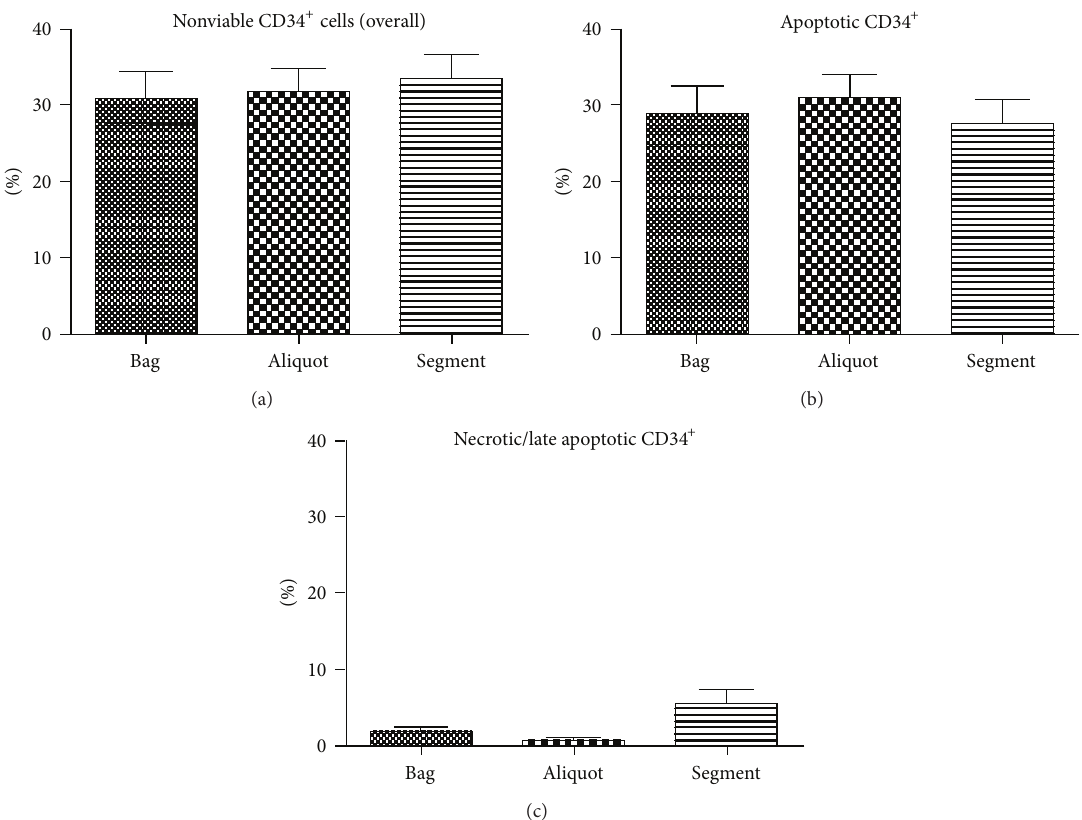
Figure 2: Comparison of Annexin V-determined viability in CD3 4 + cells after thawing between bag, aliquot, and segment. Viability of CD3 4 + cells after thawing ( 𝑛 = 5 ) was assessed, and the resulting necrotic and apoptotic percentages were summed up to obtain nonviable HSC percentage (a). Additionally, apoptotic (b) or necrotic percentages (c) were compared, respectively. factor 4 (ranging from 29 to 115 CD3 4 + cells per 𝜇